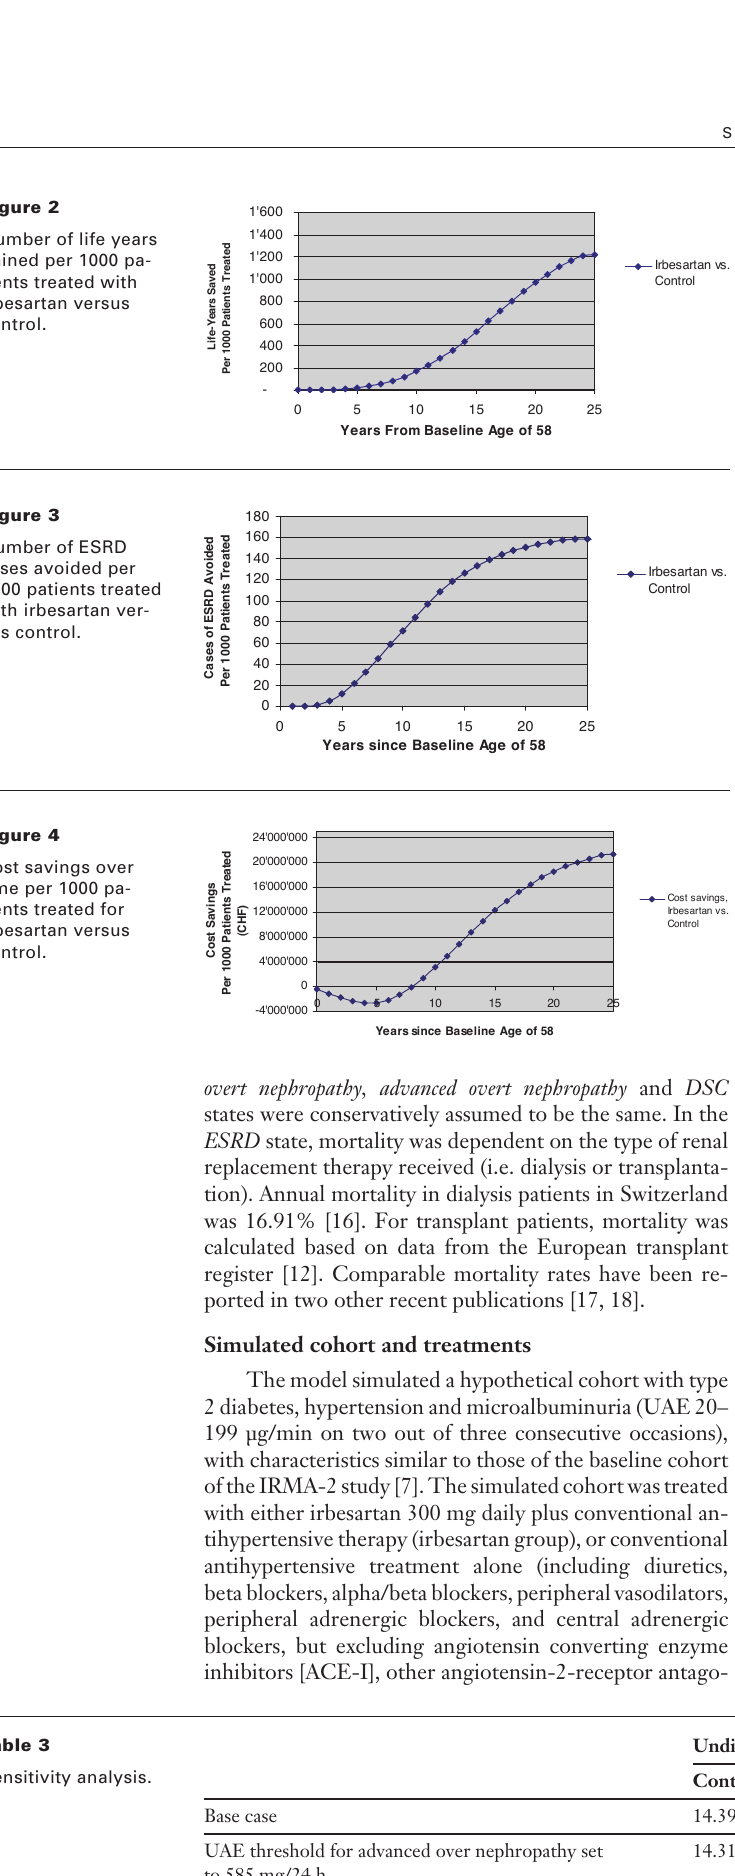
Figure 2 Number of life years gained per 1000 pa- tients treated with irbesartan versus control.